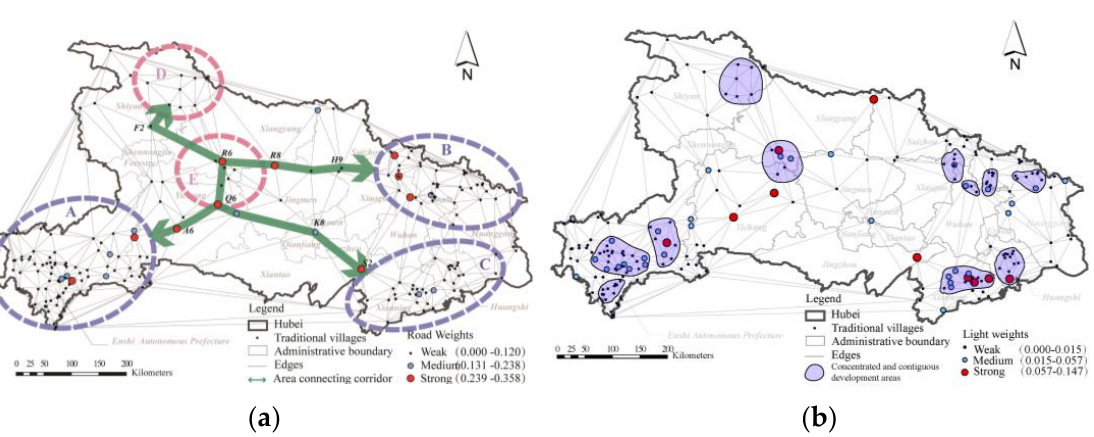
Figure 8. Diagram of the policy and planning proposals. ( a ) A diagram to improve the accessibility of 5 clusters; ( b ) A planning for the concentrated development of traditional villages.